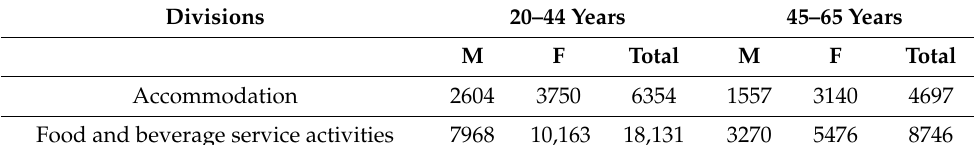
Table 2. The number of employees in sector I in 2019 by age, gender and divisions.